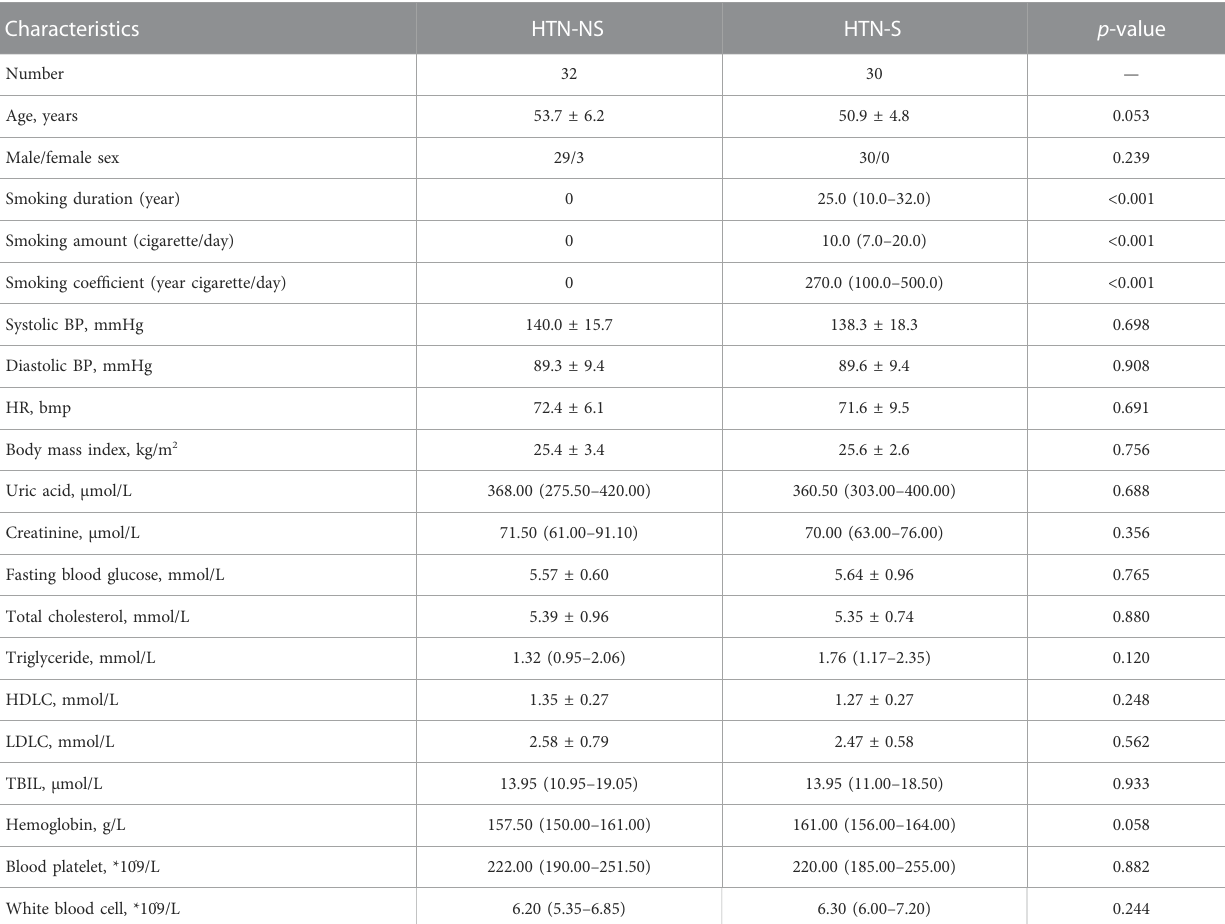
TABLE 1 General characteristics of study